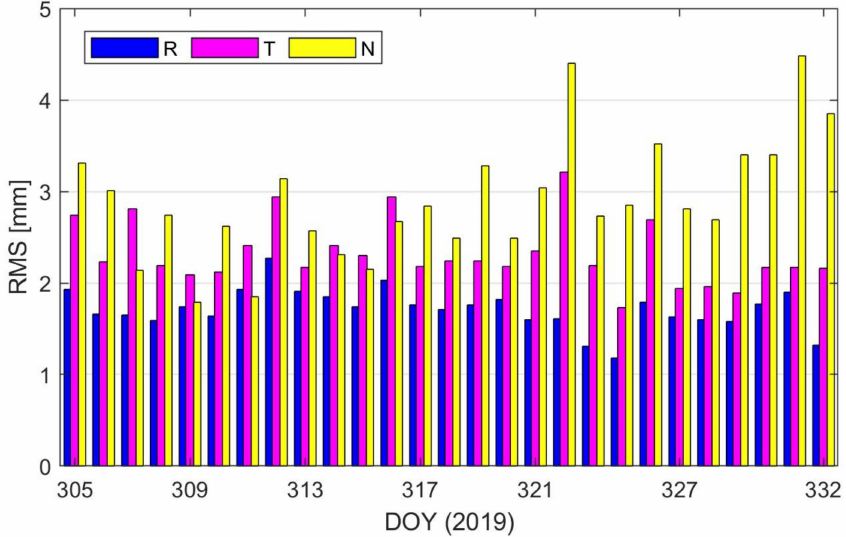
Figure 6. Difference between the differential POD (dPOD) and precise relative orbit determination (PROD) solutions of